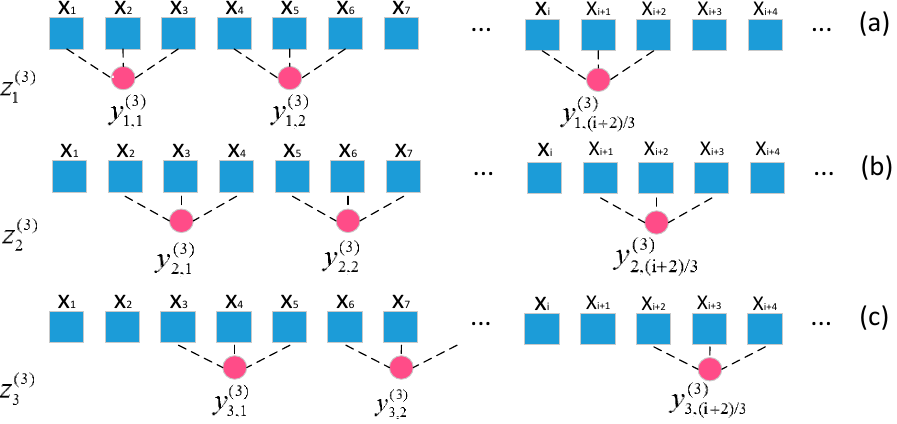
Figure 7. The diagram of the coarse granulation process when τ = 3. ( a ) The computational process ( 3 ) of z . ( b ) The computational process of z 1